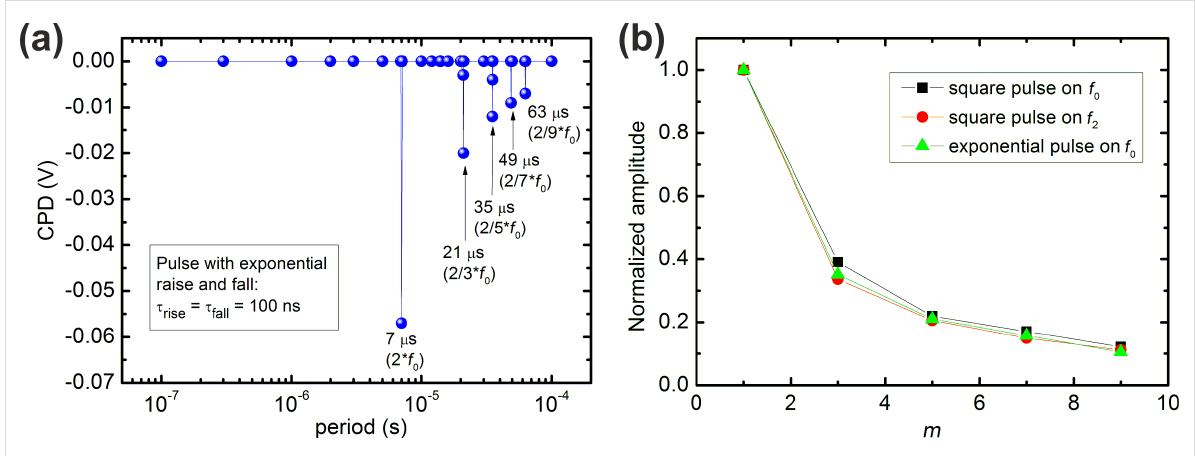
Figure 3: (a) Frequency spectrum for bias modulation with exponential rise and fall shape, as illustrated in Figure 1f. The characteristic time constant of the exponential rising and falling slopes are τ rise = τ fall = 100 ns. The pulse height and width are V pulse = 0.5 V and w pulse = ½ period, respectively. As in previous cases, a dc-bias voltage of − 250 mV is included. The detection ac frequency was applied at the fundamental cantilever resonance ( f ac = f 0 = 71.429 kHz). (b) Normalized amplitude of the CPD deviations as a function of the factor m (see text for details).